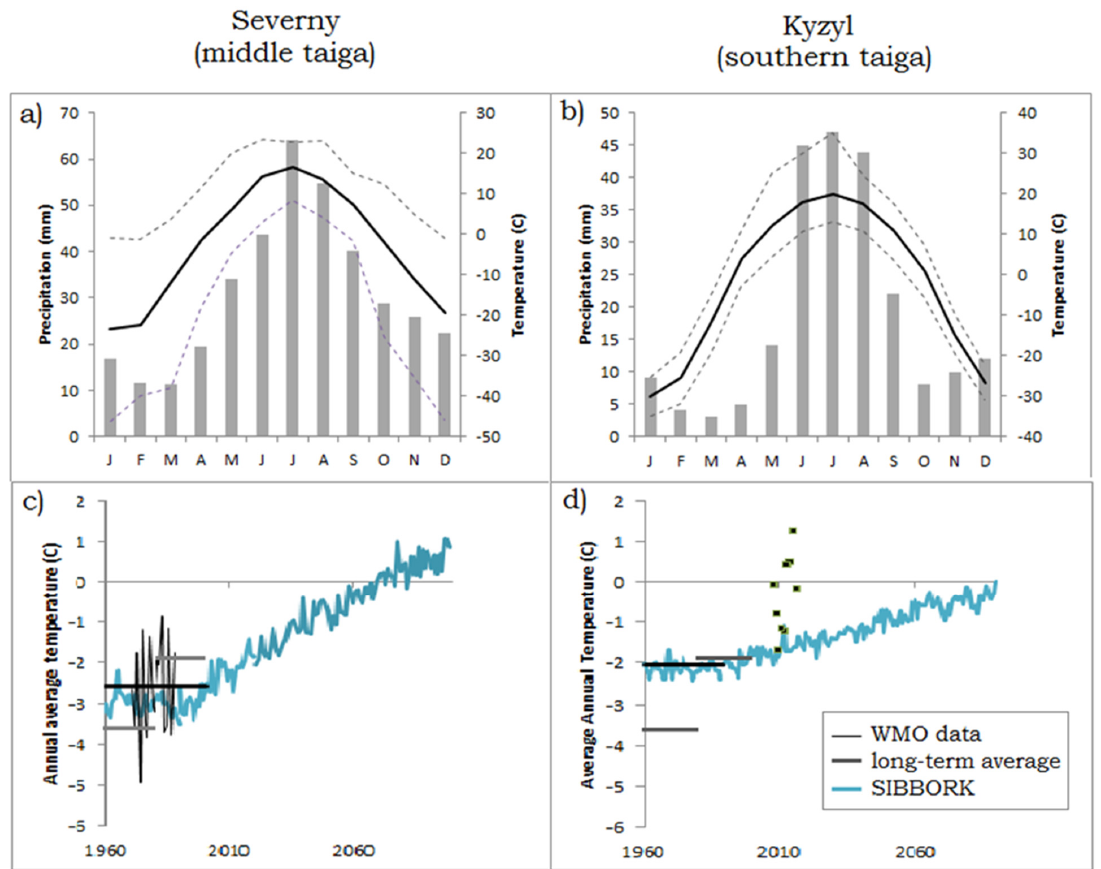
Figure A1. The simulation of climate in the SIBBORK model is driven by average monthly temperatures and the associated standard deviations, monthly maximum and minimum temperatures, and monthly precipitation sums. These values were obtained from the World Meteorological Organization records for stations ( a ) Ust’-Ilimsk (#30117) and ( b ) Kyzyl (#36096) for the 1960–1990 timeframe. Average annual temperature for the two simulated sites is shown in blue for the ( c ) Severny leskhoz and the ( d ) southern boreal boundary. These output values are compared to multidecadal averages for 1960–1980 and 1980–2000 timeframes, as well as to recent observations from 2008–2016. Simulated average annual temperatures are a conservative estimate obtained by extrapolating observed [22] seasonal trends for the regions.